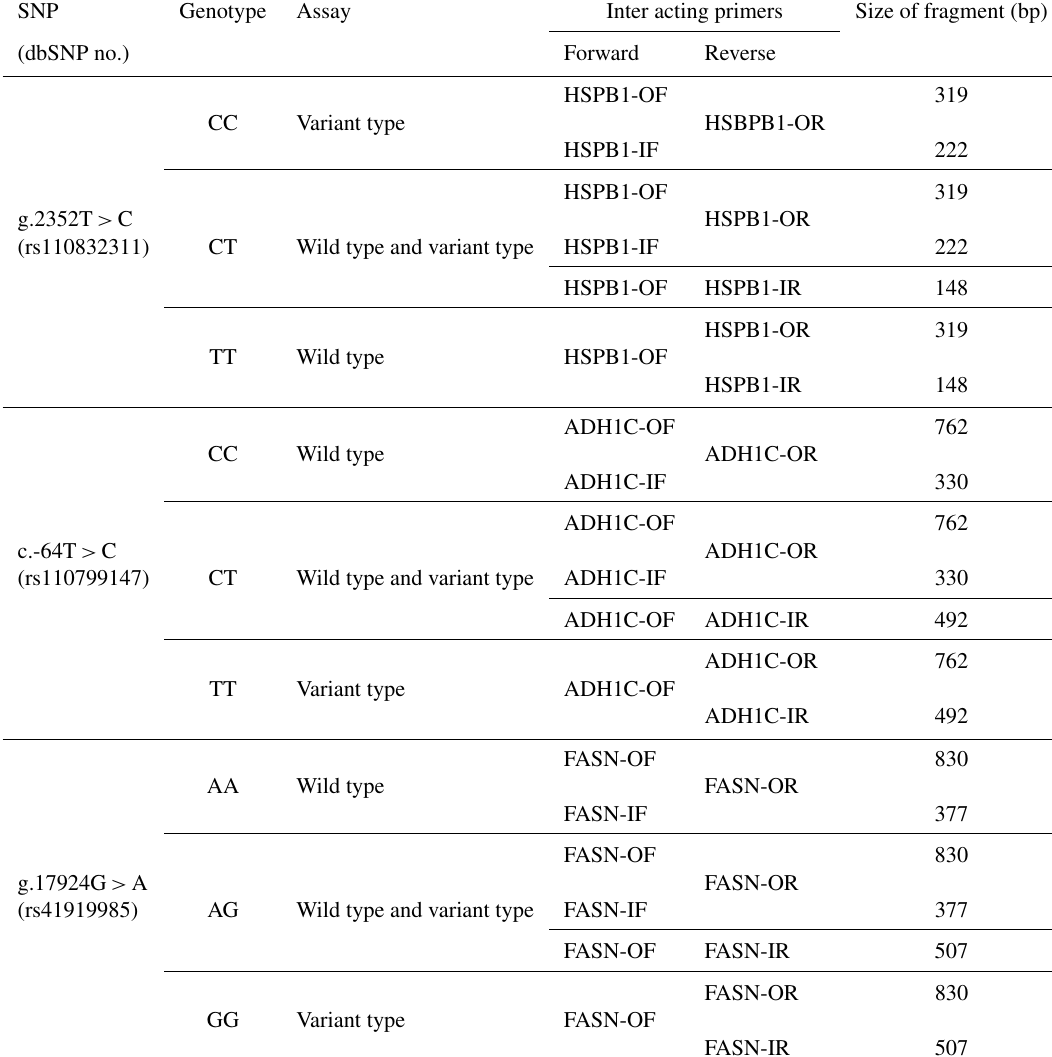
Table 2. Different sizes of amplicons according to use of paired primers for different SNPs. SNP Genotype